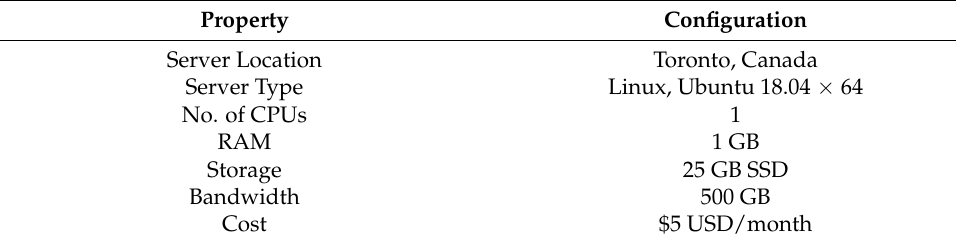
Figure 1. Location Transparency Call (LTC) system overview. Table 1. Basic configuration of the VPS instance used in